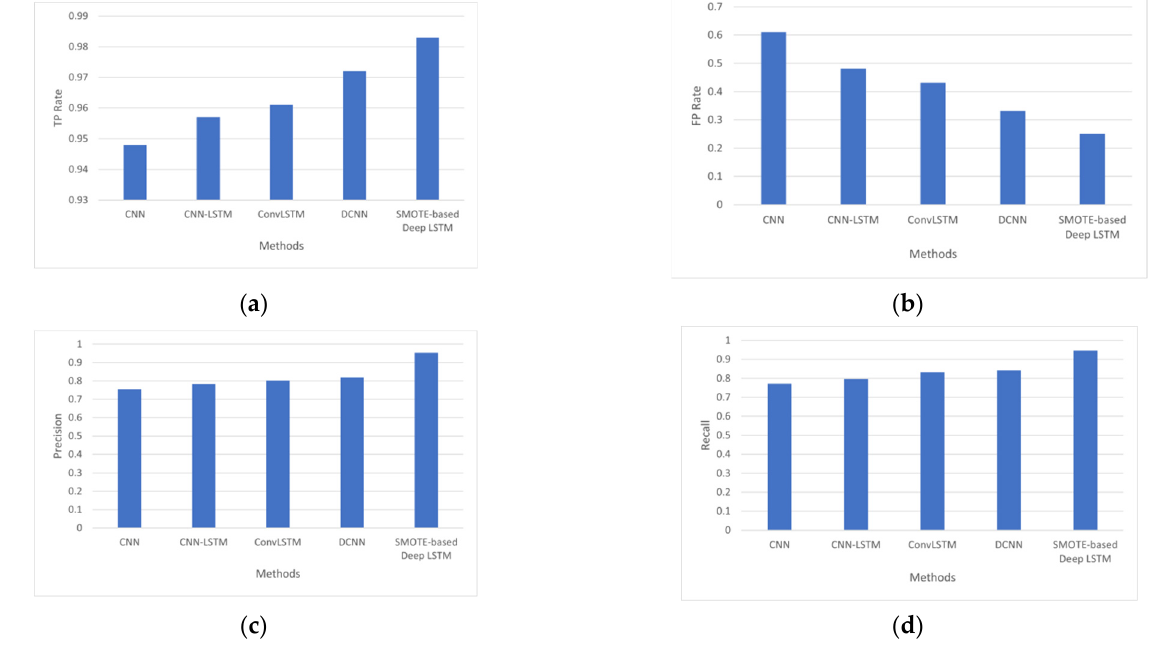
Figure 2. ( a ) Analysis based on TP Rate, ( b ) analysis based on FP Rate, ( c ) analysis based on precision, and ( d ) analysis based on recall.